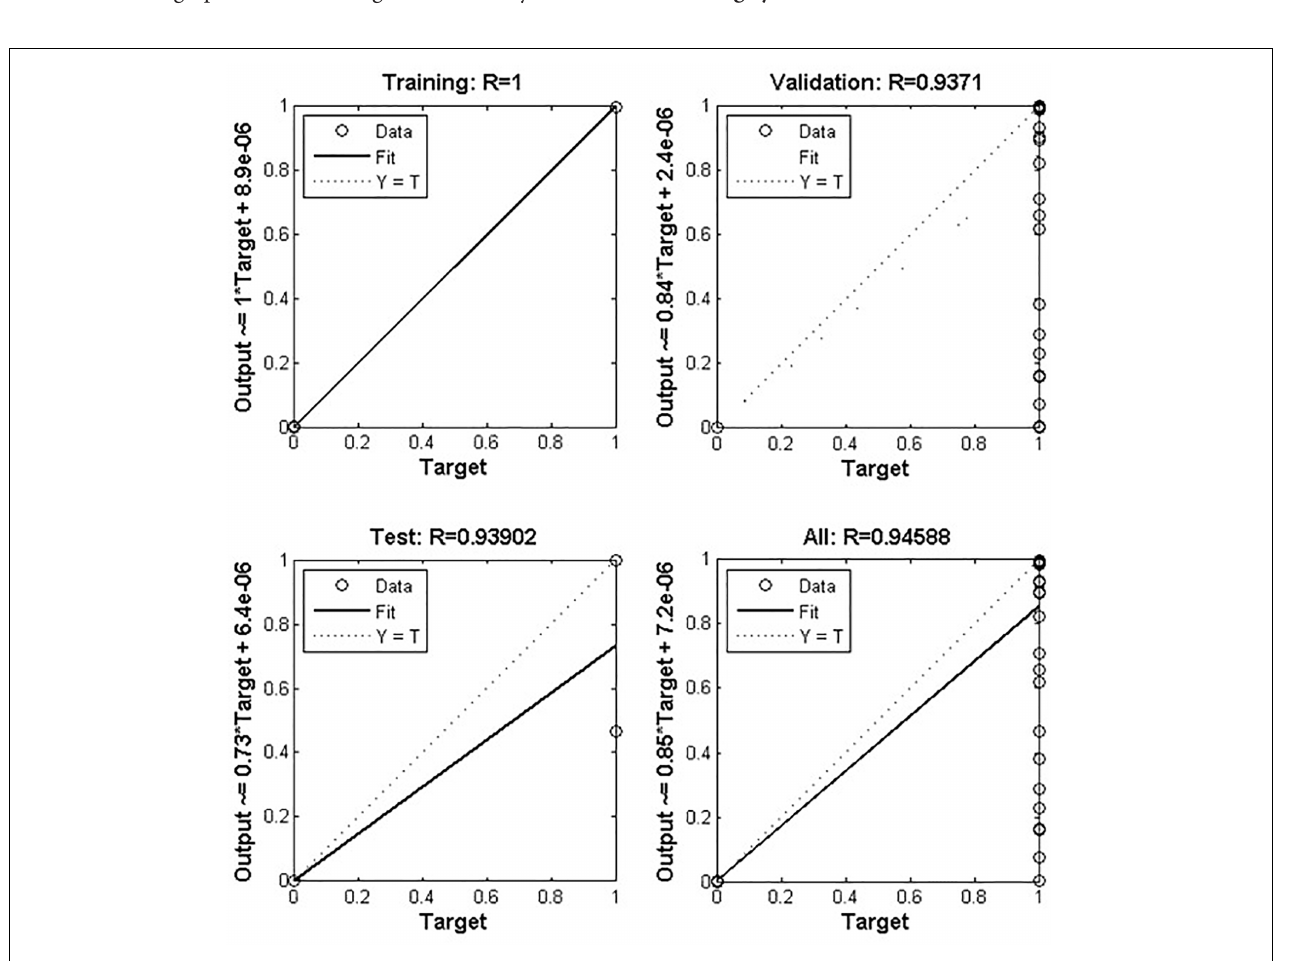
FIGURE 3 | Depicts artificial neural network prediction on the basis of normalized data of MTB. Out of 12636 records, 70% was training and 30% was test set where the validation score was achieved with an accuracy of about 94%. The overall model got an accuracy of 94.58%.